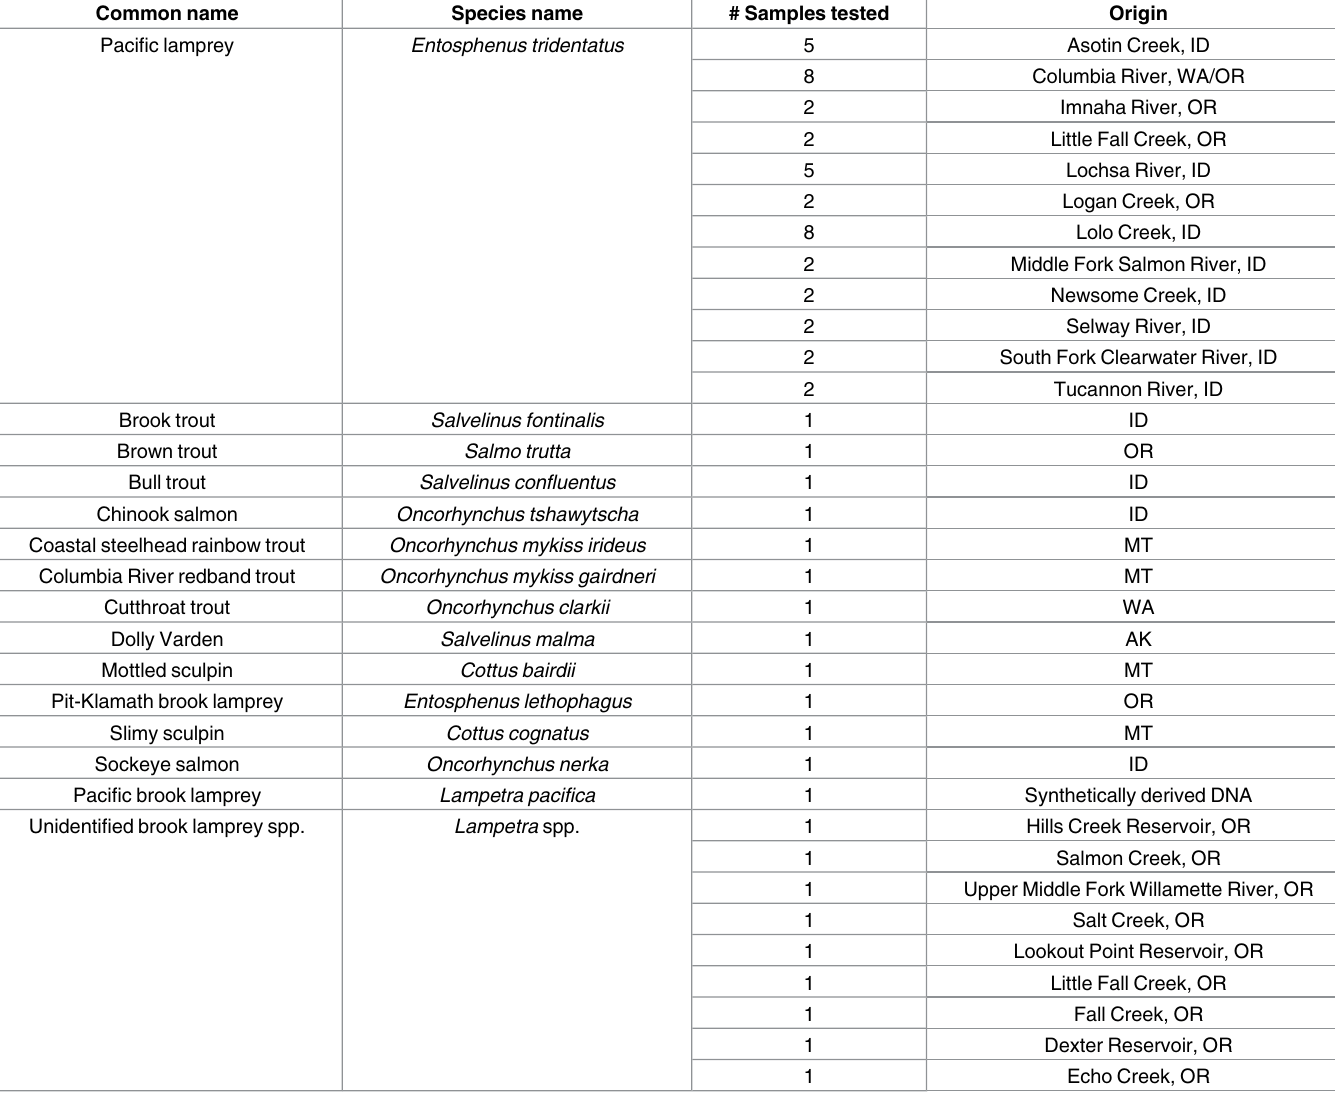
Table 3. List of species used for in vitro screening of the qPCR primers and probe. Origin refers to the waterbody for Pacific lampreysamples; origin is listed as state for all other